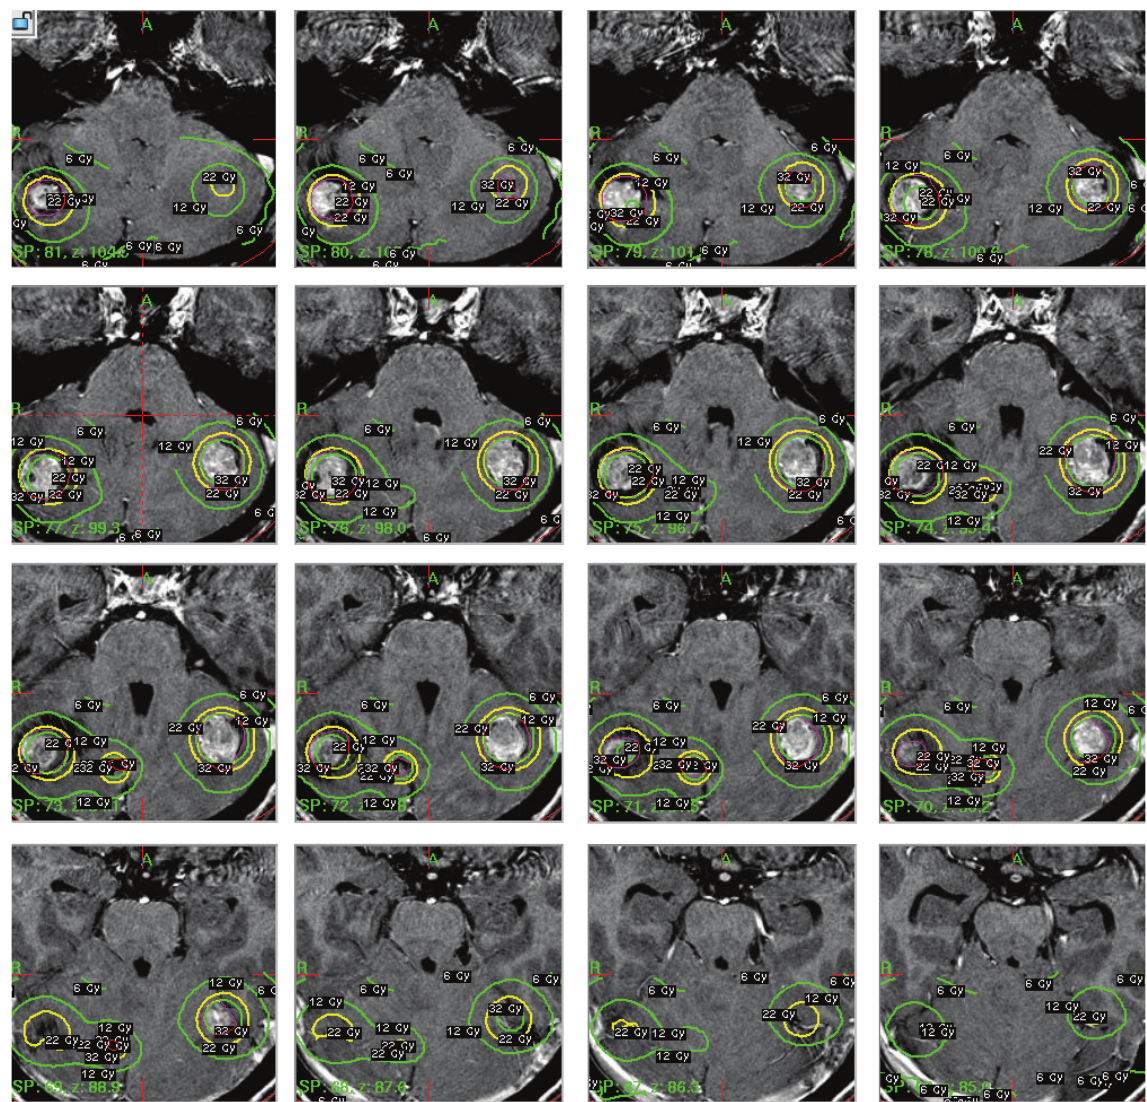
Figure 1: Multiple T-1 postgadolinium axial images illustrating tumor location and Gamma Knife isodose plans (22 Gy, 50% isodose